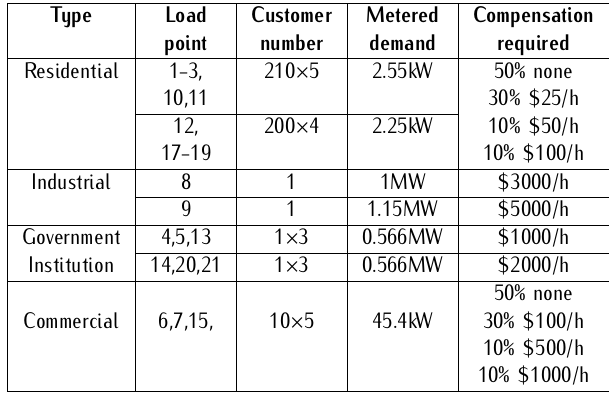
Table 2. Simulation data used as in RBTS Bus